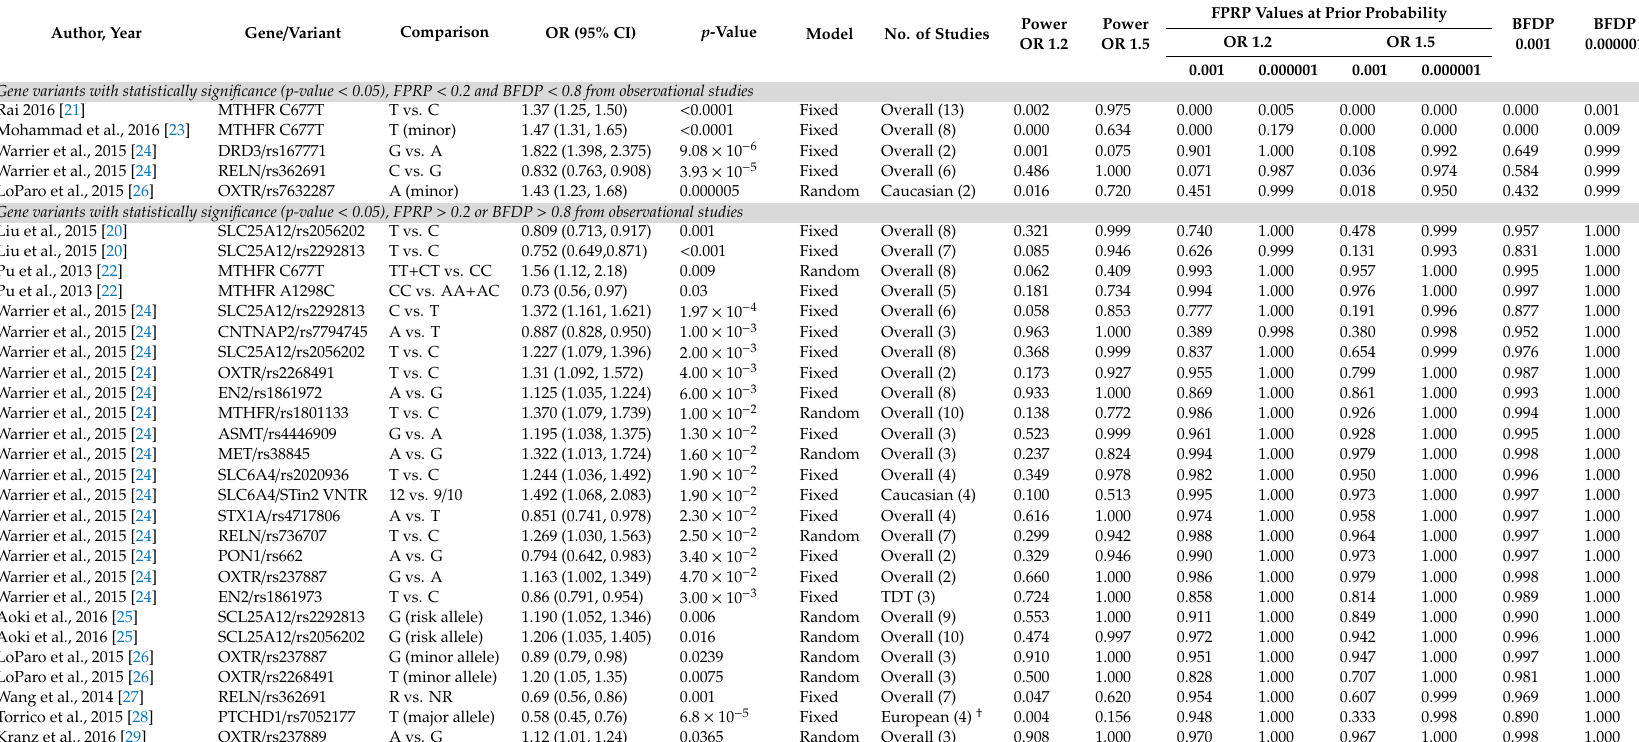
Table 1. Re-analysis results of gene variants with statistical significance ( p -value < 0.05) from observational